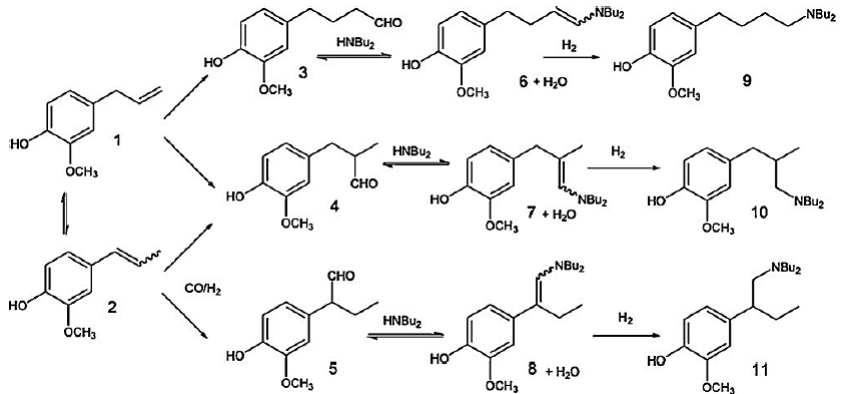
Figure 14. Hydroaminomethylation of eugenol with di- n -butylamine. Reprinted from [79] with permission from Elsevier.